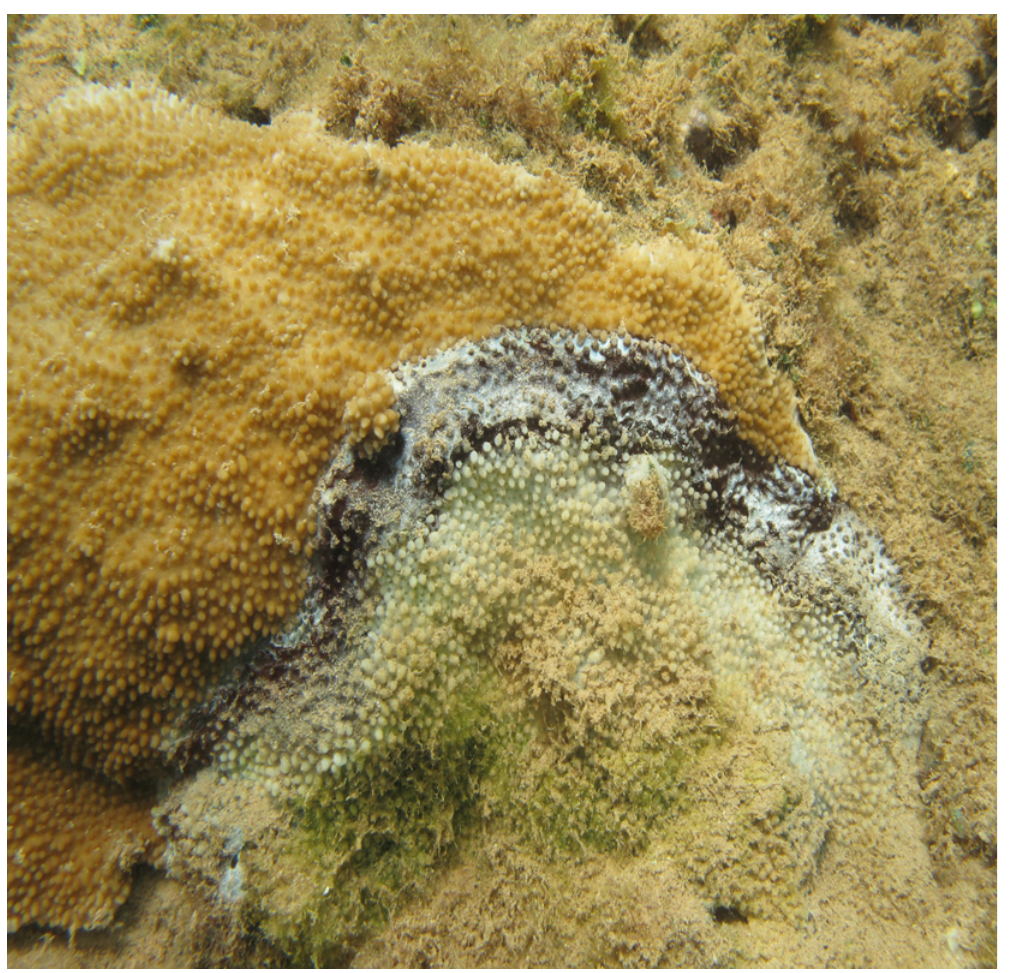
Fig 1. Montipora capitata colony with signs of black band